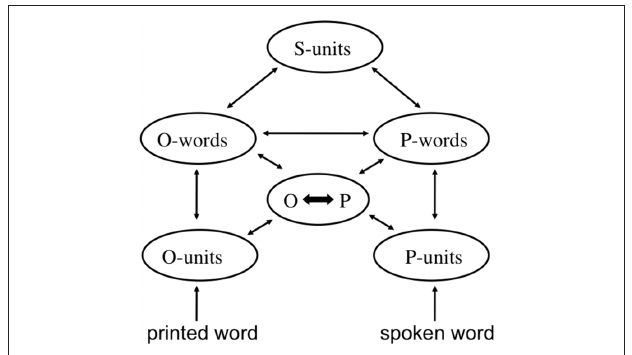
Figure 1 | generic architecture of the bi-modal interactive-activation model (BiAM). A distinction is drawn between sublexical and lexical orthographic (O-units, O-words) and phonological (P-units, P-words) representations that interact via a central interface (O ↔ P). Whole-word representations provide access to semantic representations (S-units).